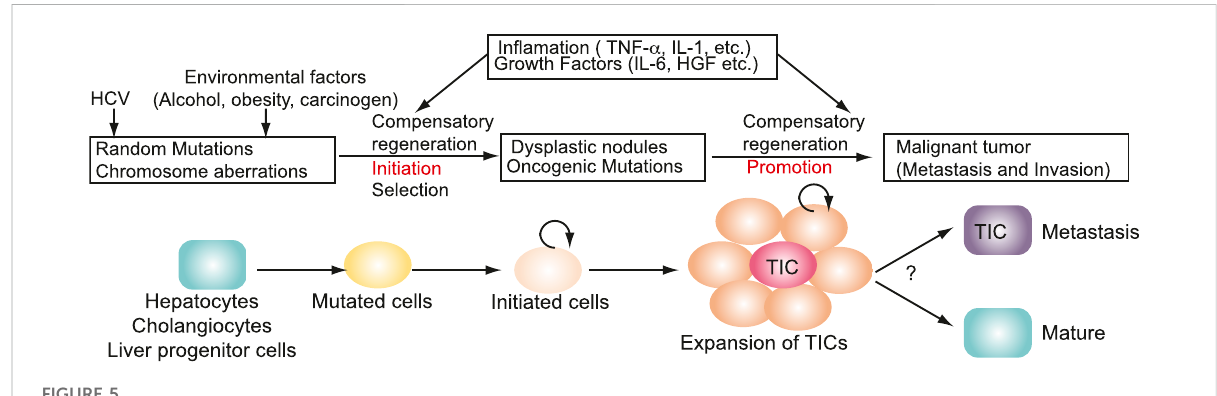
FIGURE 5 Genesis of TICs in HCV carcinogenesis. Environmental factors (alcoholism, obesity and carcinogen exposure) and HCV infection are invoved in initiation and promotion. Transformed cells are further altered and progressed to TICs. Expansion of TICs requires self-renewal property. TICs acuired tumor-initiation